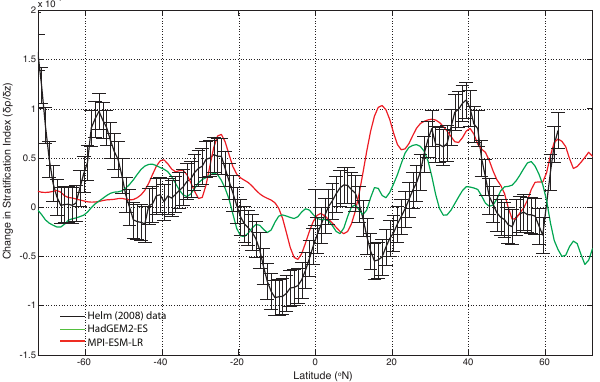
Fig. 6. Zonal mean change (~1992 minus ~1970) in upper ocean stratification as a function of latitude from observations (black; Helm [2008]), and HadGEM2-ES (green) and MPI-ESM-LR (red) historical integrations. The Stratification Index is calculated as the vertical density gradient ( δρ / δ z ) between 200 m and 1000 m depth. Model stratification is estimated by calculating density (kg m -3 ) from CMIP5 historical temperature and salinity fields at 200 m and 1000 m depth levels. Positive values indicate an increase in upper ocean stratification over time. These stratification changes differ from those presented by Helm et al. (2011) because we exclude surface data (<100 m) from Hadley SST climatology. Error bars for observed stratification changes are given at the 95 % confidence level as in Fig. 3.